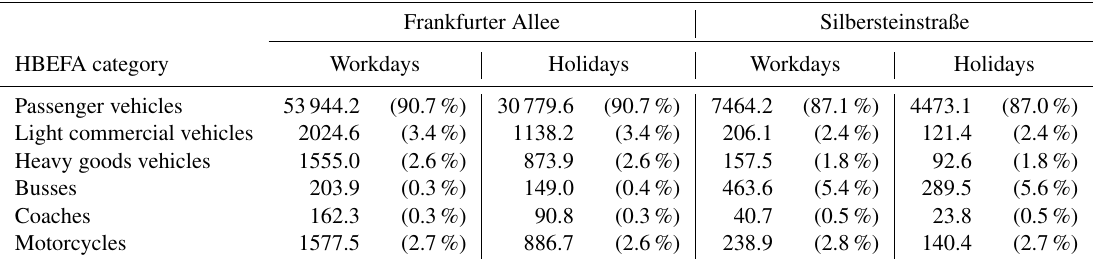
Table A1. Mean daily traffic count for typical workdays and holidays on Frankfurter Allee and Silbersteinstraße in Berlin, classified by HBEFA vehicle categories.